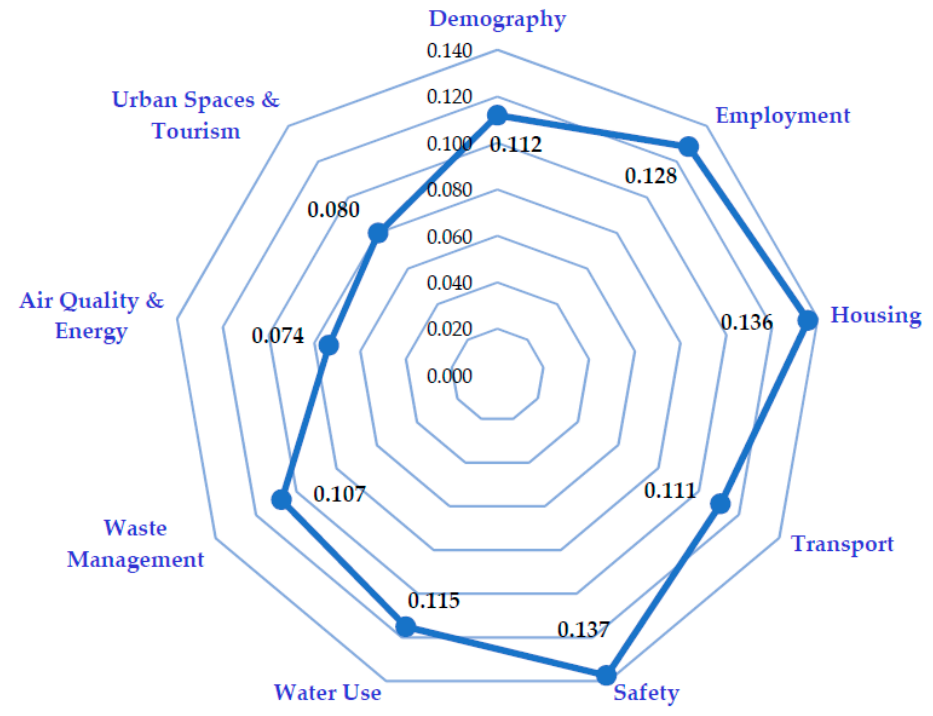
Figure 5. Relative weights of the nine criteria.